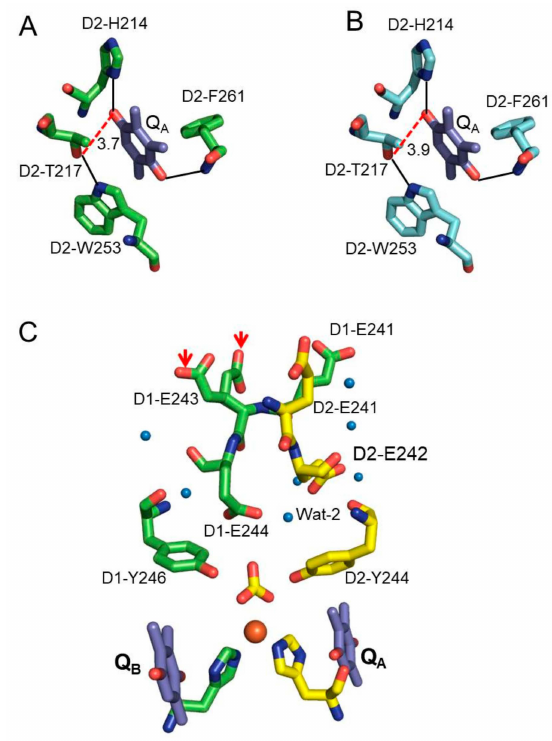
Figure 3. The immediate environment of Q A and its relationships with the distant stromal Glu residues. ( A ) The interactions of Q A with nearby residues and the additional H-bond (red dashed line) with D2-T217 and ( B ) the corresponding environment of Q A in the Ca-PSII model. ( C ) The distant stromal Glu residues and associated water molecules. The red arrows indicate the rotamers of the D1-E243 residue in the Sr-PSII